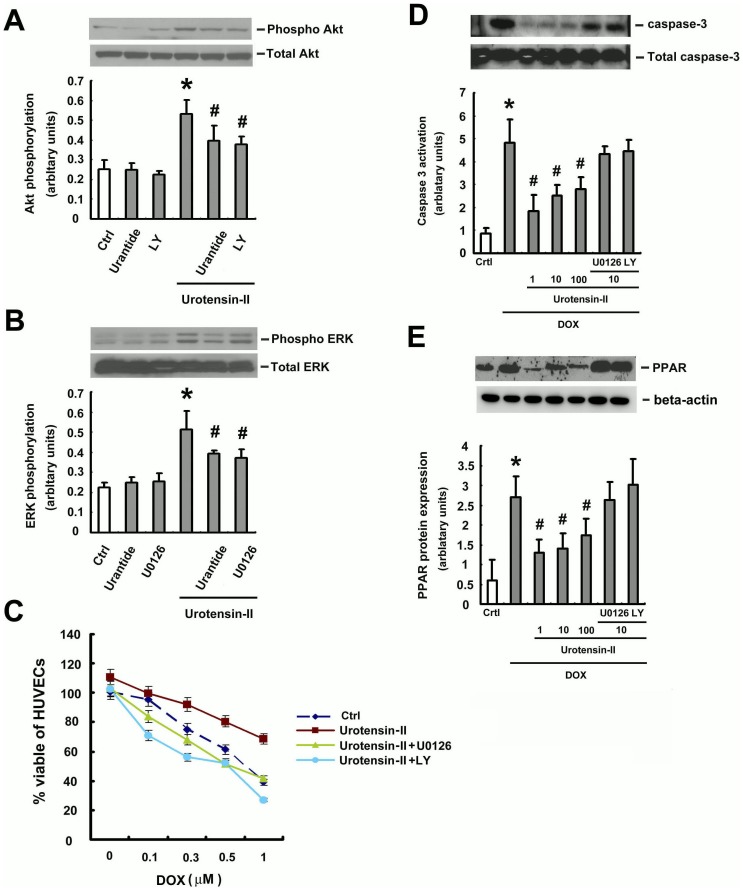
The protective effect of U-II depends on the PI3K/Akt or ERK pathway.HUVECs were pretreated with U-II antagonist urantide and PI3K/Akt inhibitor (A) and ERK inhibitor (B) 0.5 h prior to U-II treatment and then incubated for 24 h with DOX (1 µM). Viability was evaluated via western blotting analysis. (C) Treatment with LY294002 (LY) and U0126 attenuated the protective effect of U-II in DOX -treated HUVECs. Densitometric data are means ± SEM from five separated experiments. *P <0.05 vs. control; #
P <0.05 vs. U-II only group. The protective effect of U-II was associated with cleavage of PARP and activation of caspases-3. Immunoblot studies showed that U-II induced an upregulation of activation of caspases-3 (D) and cleavage of PARP (E) in DOX-treated cells in the presence of LY294002 or U0126. Densitometric data are means ± SEM from three separated experiments. *P <0.05 vs. control (Ctrl); #
P <0.05 vs. DOX treatment.